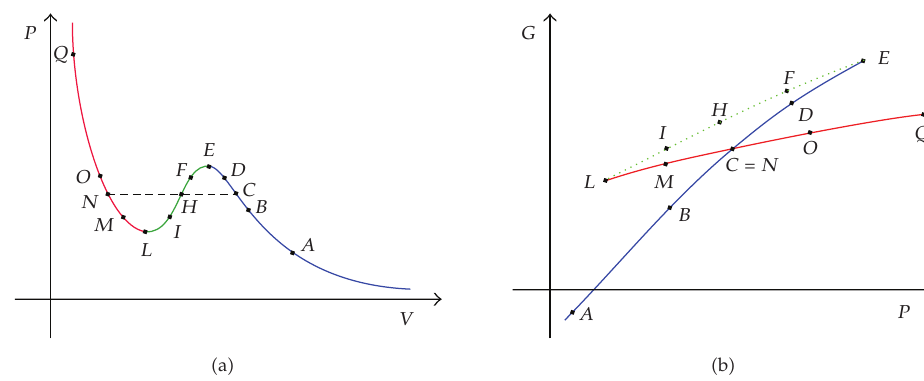
Figure 16: The pressure P as a function of the volume V (cid:5) a (cid:6) and the Gibbs free energy G as a function of the pressure P (cid:5) b (cid:6) for the same isotherm curve (cid:3) 58 (cid:4)